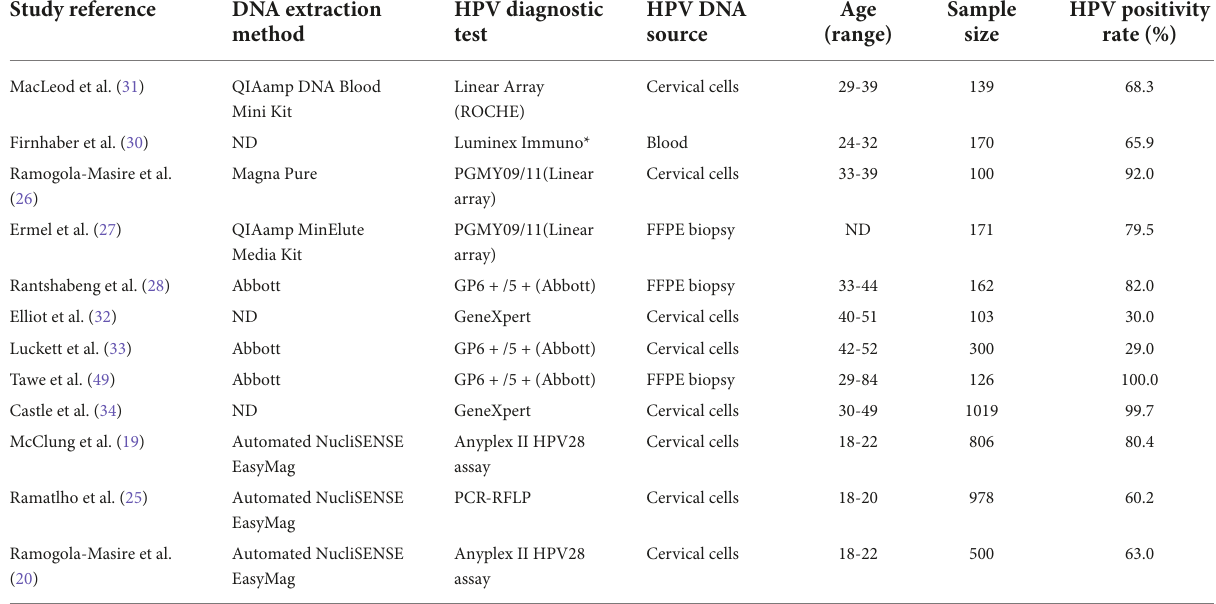
TABLE 1 List of the included studies from